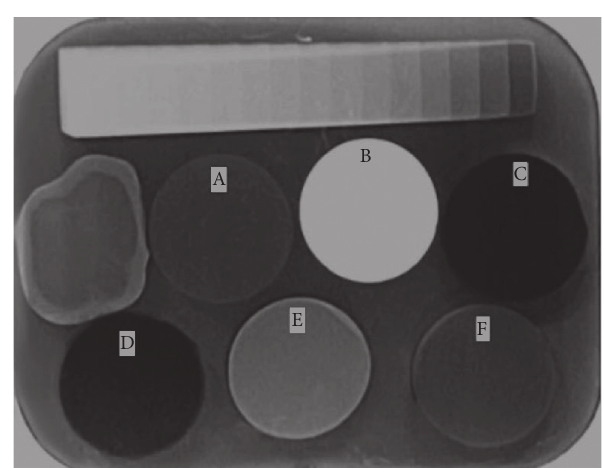
Figure 1: Digital radiograph of each CAD/CAM restorative ma- terial specimen, tooth structure slice, and aluminum step-wedge. (a) Shofu. (b) Prettau. (c) BioHPP. (d) Pekkton. (e) Vita Suprinity. (f) Vita